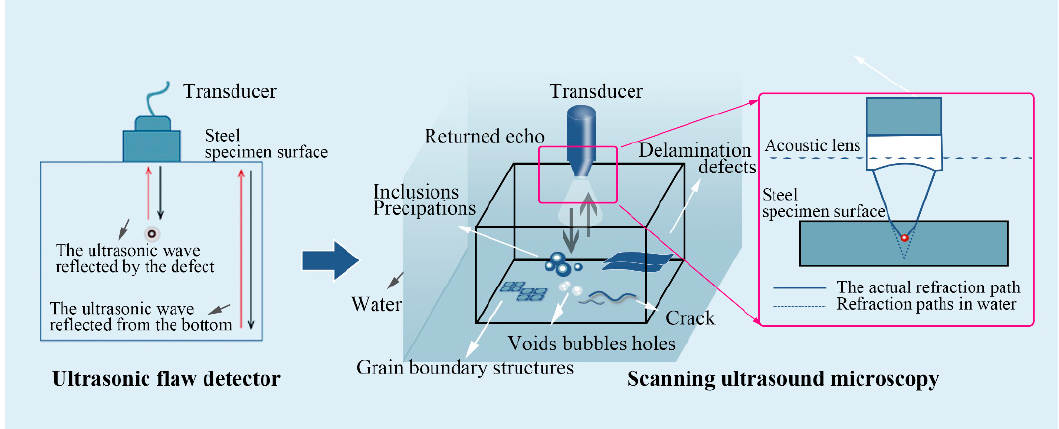
Figure 2. Testing principle of the ultrasonic instrument.